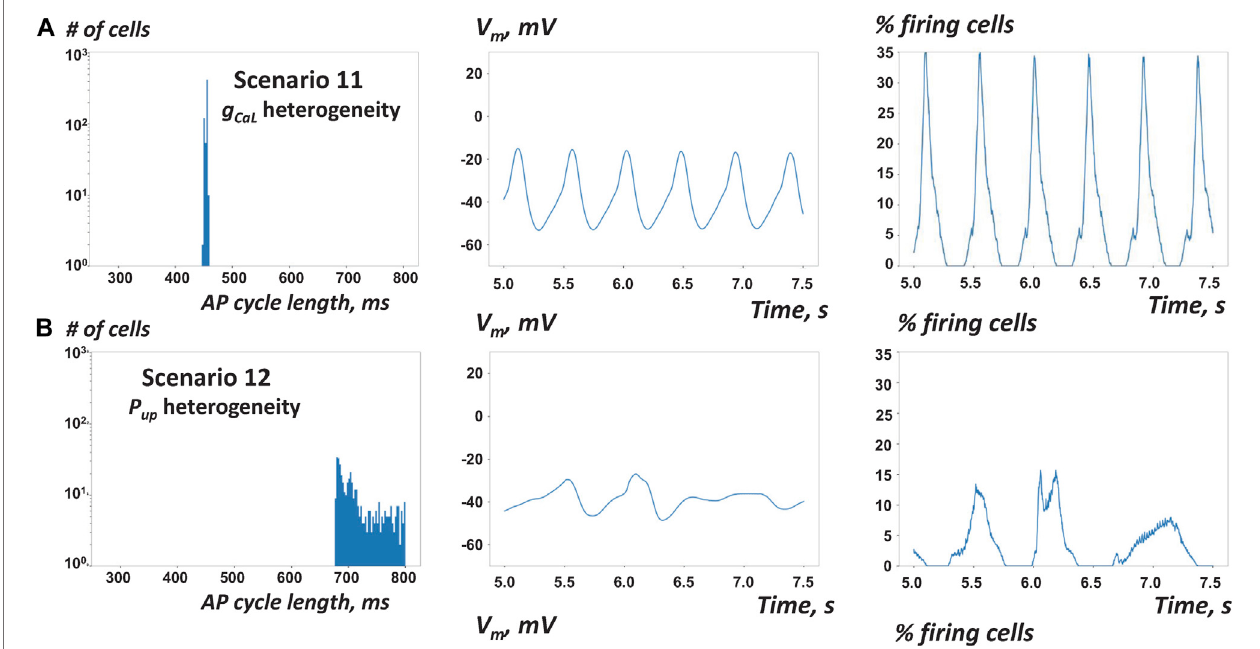
FIGURE7| Results ofsimulations ofSANtissuefunctionwithstronger cell-to-cellcoupling (A) With stronger cellcoupling at ρ =10 3 M Ω · m vs10 4 M Ω · m(scenario 11vs2)AP fi ringintissue withheterogeneous g CaL became slightlyslower,but moresynchronized (almostmetronomic, SupplementaryMovieS11 ) (B) With stronger cell coupling in tissue with heterogeneous P up (scenario 12 vs 5) AP fi ring in tissue with heterogeneous P up became substantially slower and remained notably